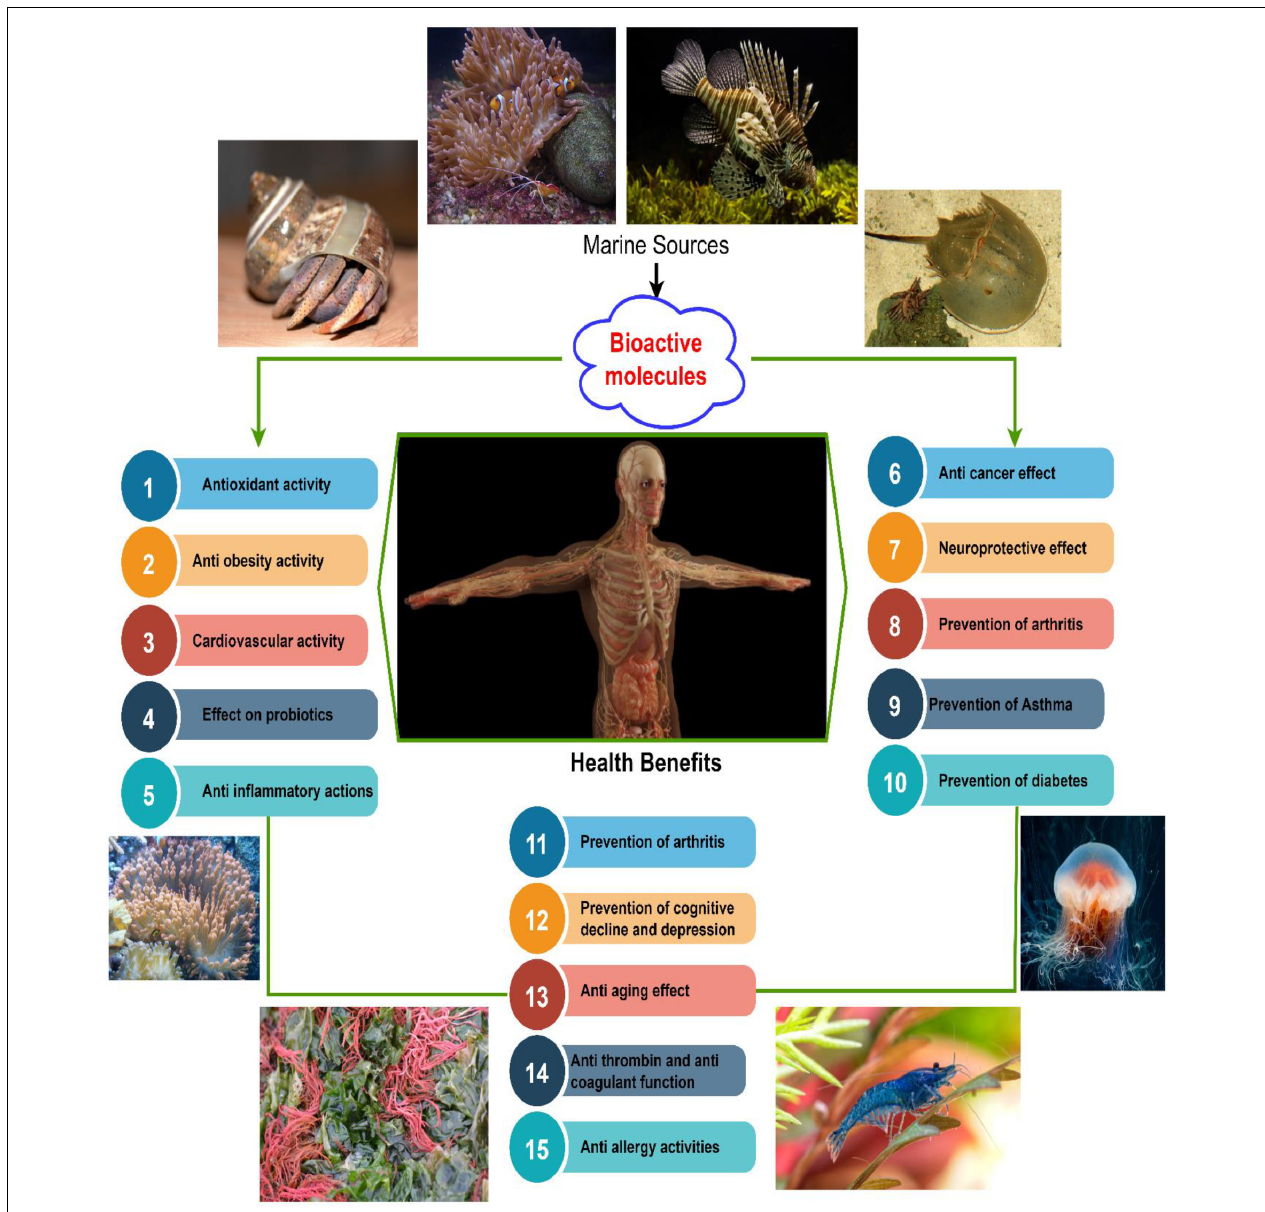
FIGURE 2 | Biomolecules from marine sources as human health beneficial